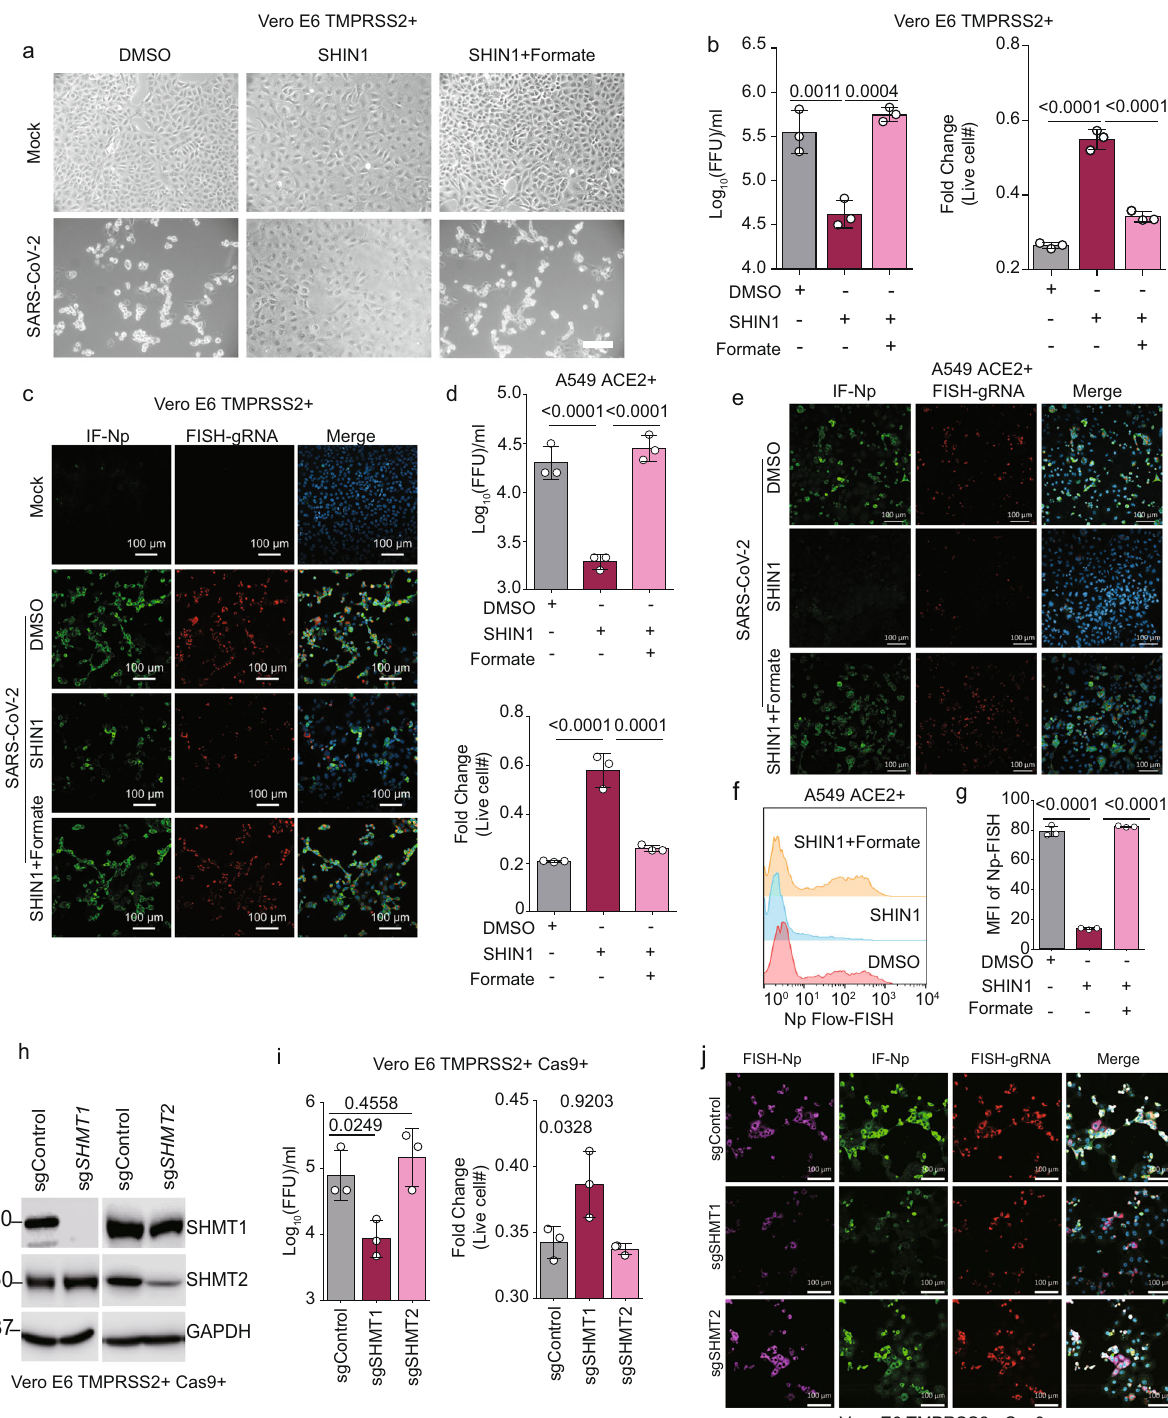
monoclonal antibody SA-46 (MAb) and Alexa Fluor 488-conjugated goat anti- mouse IgG IgG was used as a secondary antibody. Fluorescent foci of infected cells were observed and counted using a phase-contrast fl uorescence microscope. Virus titers were presented in number of fl uorescent-focus units per ml (FFU/ml). Inhibitors and special media conditions . The small molecules methotrexate (Selleckchem, S1210), hypoxanthine (Sigma, H9636), thymidine (Sigma, T1895), and sodium formate (Fisher Scienti fi c, S648-500) were used. The dual SHMT1/2 inhibitor SHIN1 (Tocris, 6998) was used at the concentration of 10 µM. In total, 1mM of sodium formate was used to demonstrate on-target effects of SHIN1. Glutamylcysteine synthetase inhibitor L -buthionine-sulfoximine (BSO; Sigma, NATURE COMMUNICATIONS| (2021) 12:1676